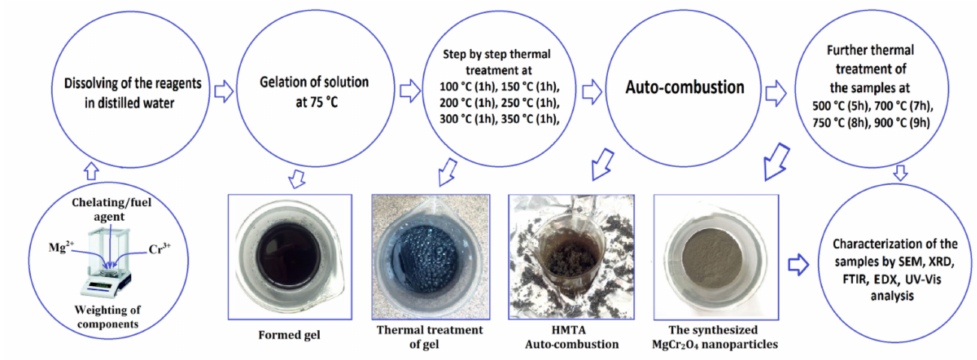
Figure 7. Schematic diagram of the synthetic route for the fabrication of MgCr 2 O 4